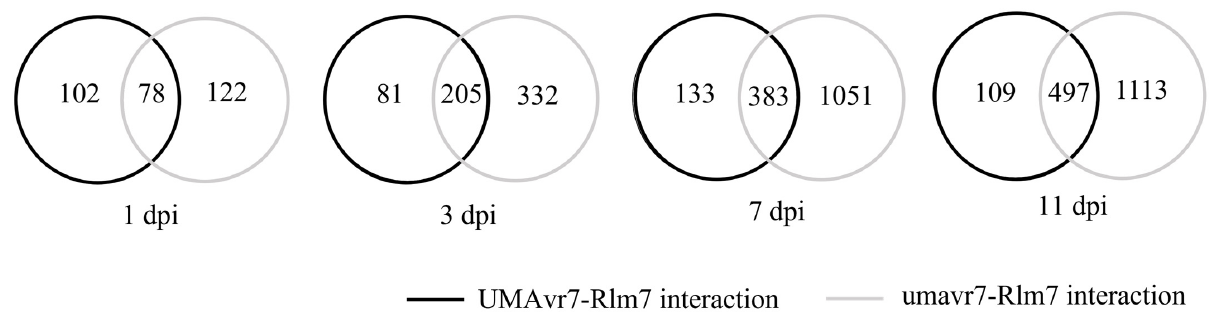
Figure 6. Unique and shared differentially expressed genes (DEGs) in two Leptosphaeria maculans isolates in interaction with 01-23-2-1 (Rlm7 line). Unique and shared DEGs in two L. maculans isolates UMAvr7 (with AvrLm7 ) and umavr7 (mutant of AvrLm7 ) in incompatible and compatible interactions with Rlm7 line at 1-, 3-, 7-, and 11-days post inoculation compared to 0-dpi analyzed by dual RNA- seq. Results were representative of three biological replicates. The results were considered at the fold-change cutoff (logFC) of ≥ 1 and ≤− 1 and false discovery rate (FDR) of ≤